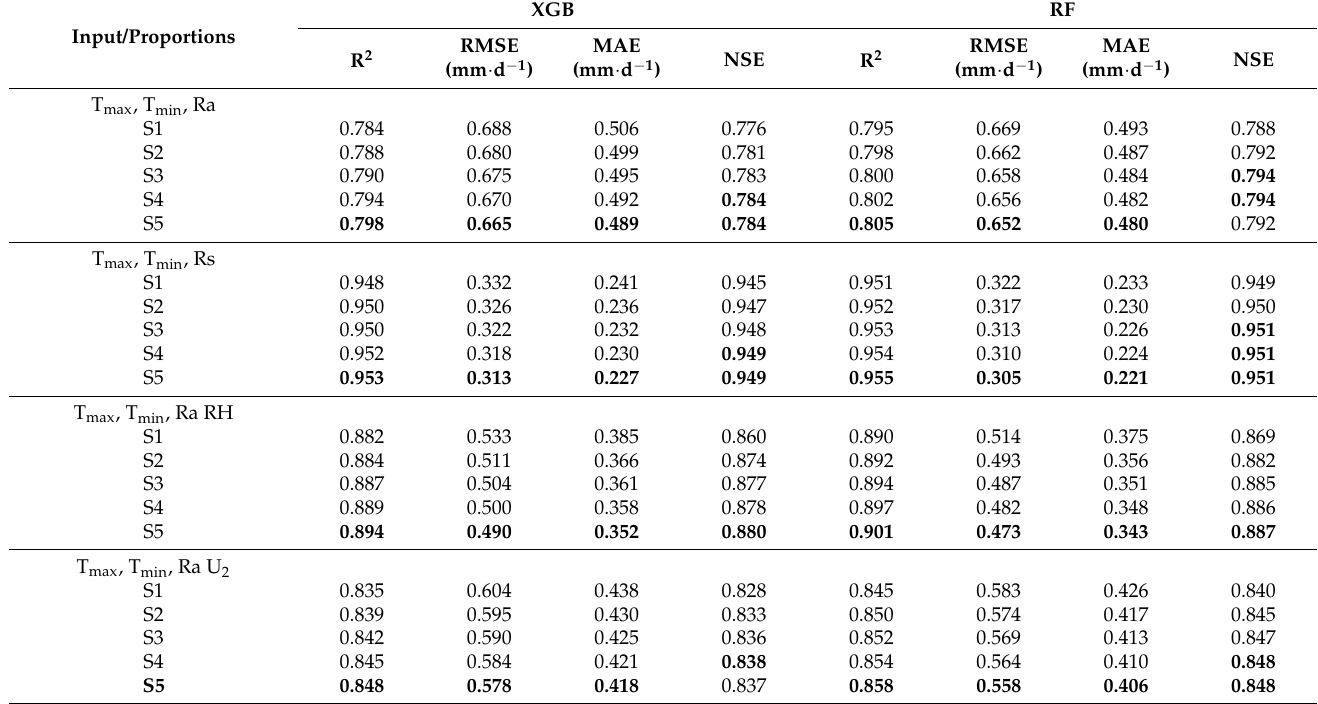
Table 4. Average statistical values of five proportions of different input parameters of two machine learning models in testing process of 21 stations